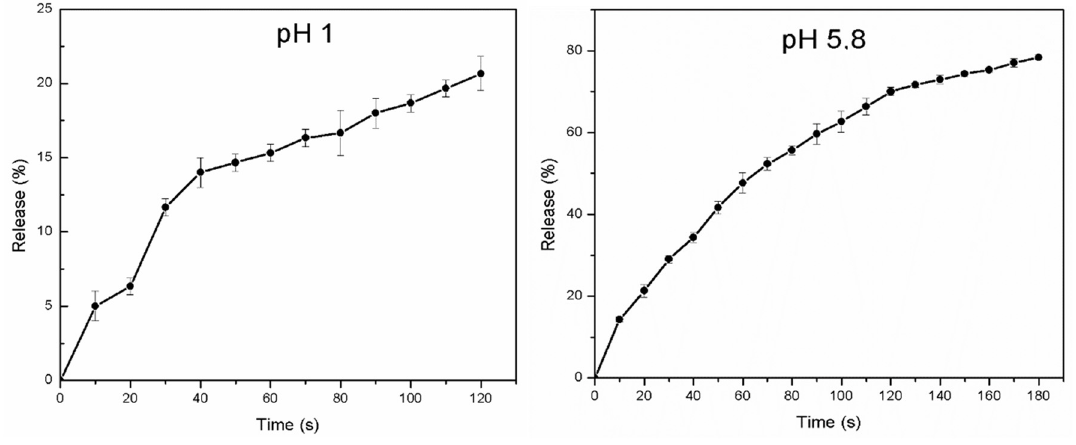
Figure 6. Microcapsule’s controlled release at pH 1 ( left ) and pH 5.8 ( right